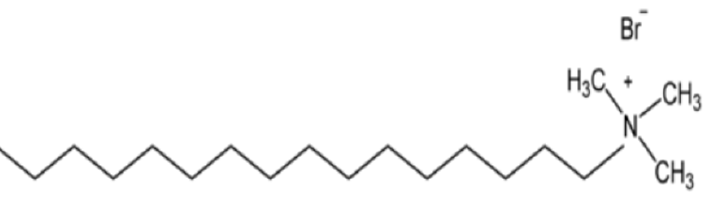
Figure 3. Chemical structure of